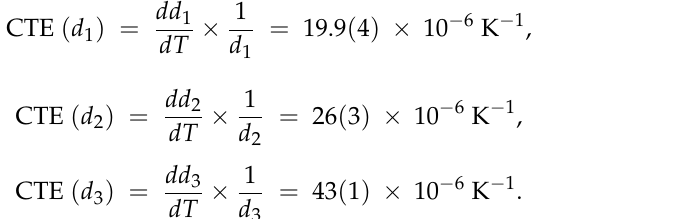
Figure 2. High-temperature synchrotron powder X-ray diffraction patterns for the NaZnSb powdered sample sealed in a silica capillary under vacuum. The “waterfall” diagram shows the evolution of XRD patterns with the concomitant change upon heating from room temperature to 868 K followed up by cooling back to room temperature. The intensity of the diffraction peaks is represented by the color intensity. Heating/cooling regions are highlighted in yellow/blue. All of the diffraction peaks can be ascribed to NaZnSb.